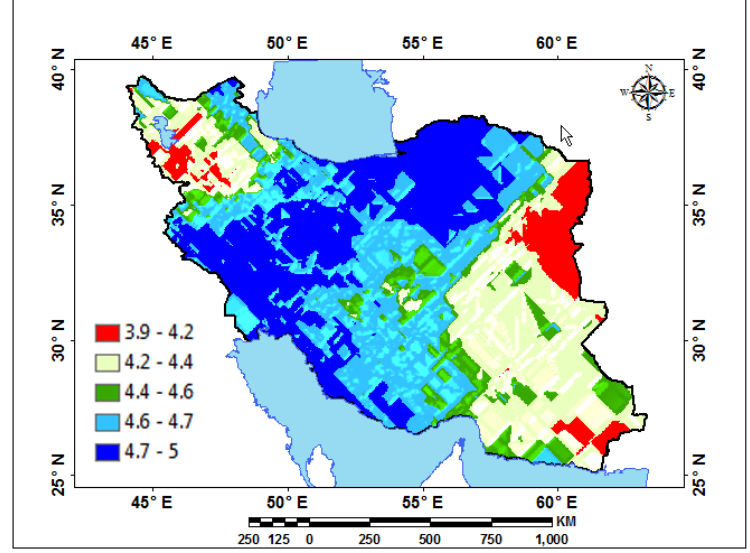
Figure 13. Forecast of summer rainfall variations (seasonal additive model).